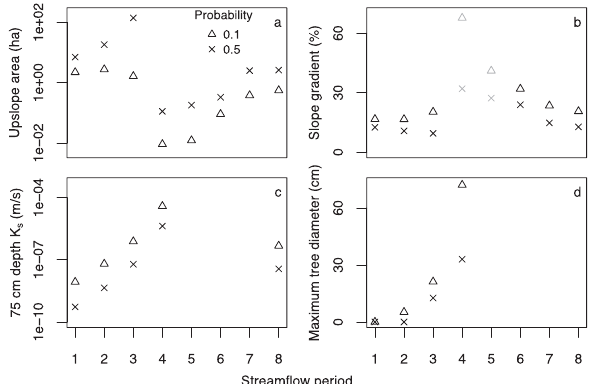
Figure 8. Variation in the predicted values of (a) upslope drainage area, (b) slope gradient (downslope gradient in black, mean slope gradient in gray), (c) deep-soil K s , and (d) maximum tree diameter for the 10 and 50% partial probabilities of groundwater response duration. For calculating partial probabilities, all other predictor variables were held at their respective mean (geometric mean for K s ) values. The streamflow periods are (1) fall transition, (2) win- ter low-flow, (3) early-melt transition, (4) rising limb, (5) peak-flow, (6) falling limb, (7) post-melt transition, and (8) summer low-flow (see Sect. 2.3.3 and Fig. 2 for